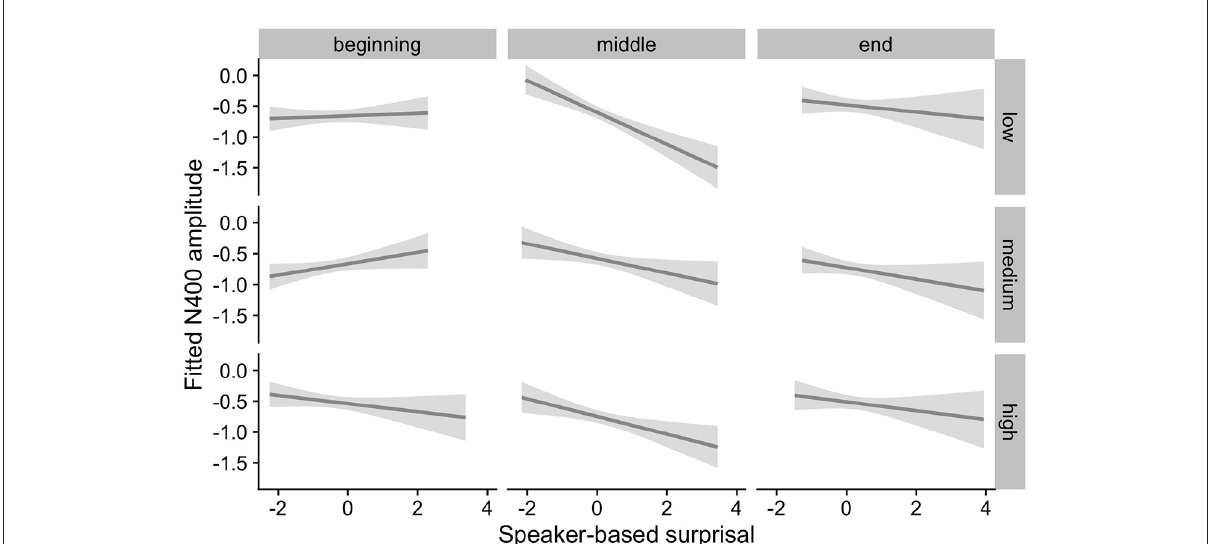
FIGURE9 Effects of ID on changes in the relationship between speaker-based surprisal (z-transformed) and N400 amplitude over the course of Experiment 2. The figure visualizes partial effects as calculated using the remef package, adjusted for Prestimulus Amplitude, Frequency and Canonicity. Note that position in the experiment (operationalised via epoch in the statistical model) is trichotomised into beginning, middle and end for visualization purposes only; epoch was included in the model as a continuous predictor. The same holds for the individual differences variables, which are trichotomised for visualization purposes but were entered into the statistical models as a continuous predictors. Shaded areas indicate 95% confidence intervals.